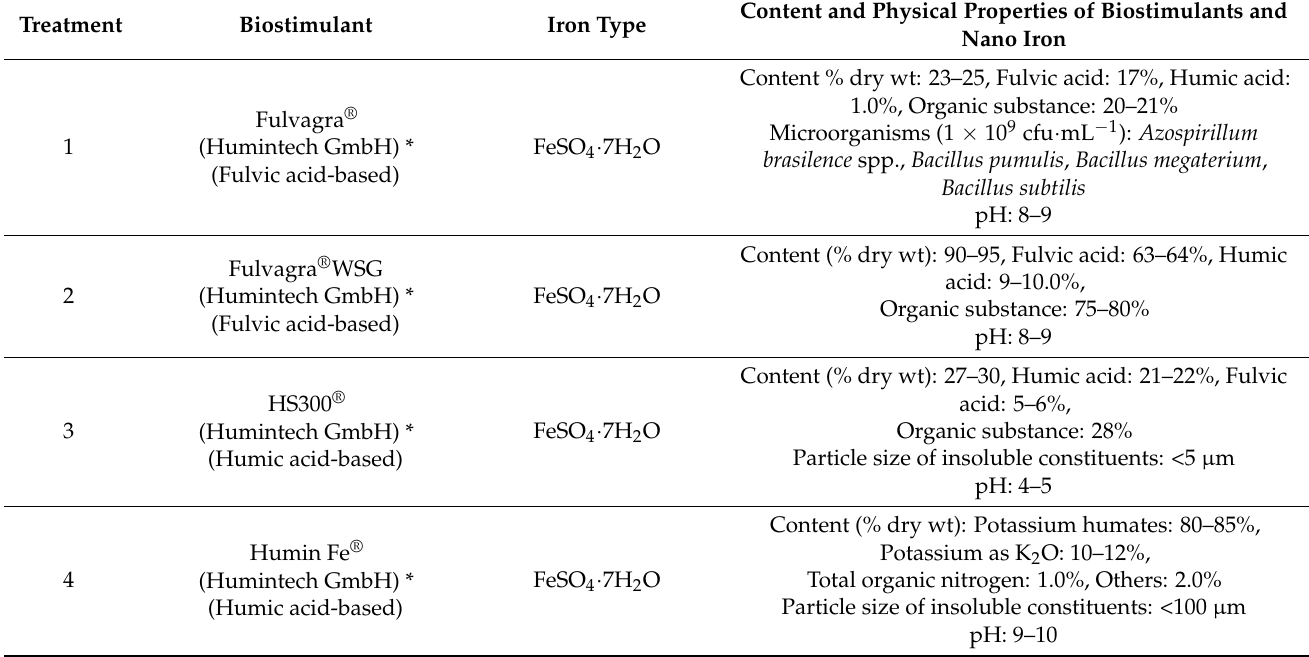
Table 1. Treatments, contents of biostimulants, and iron products